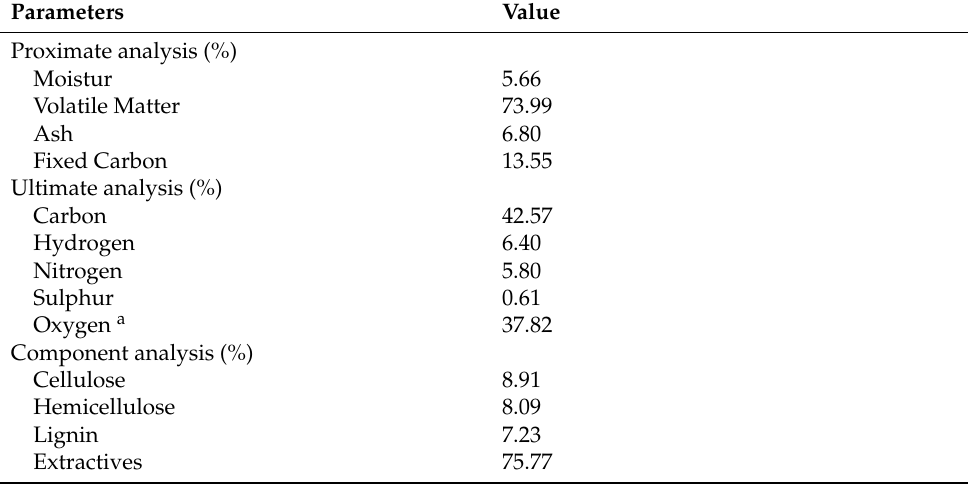
Table 1. Characteristics of rapeseed